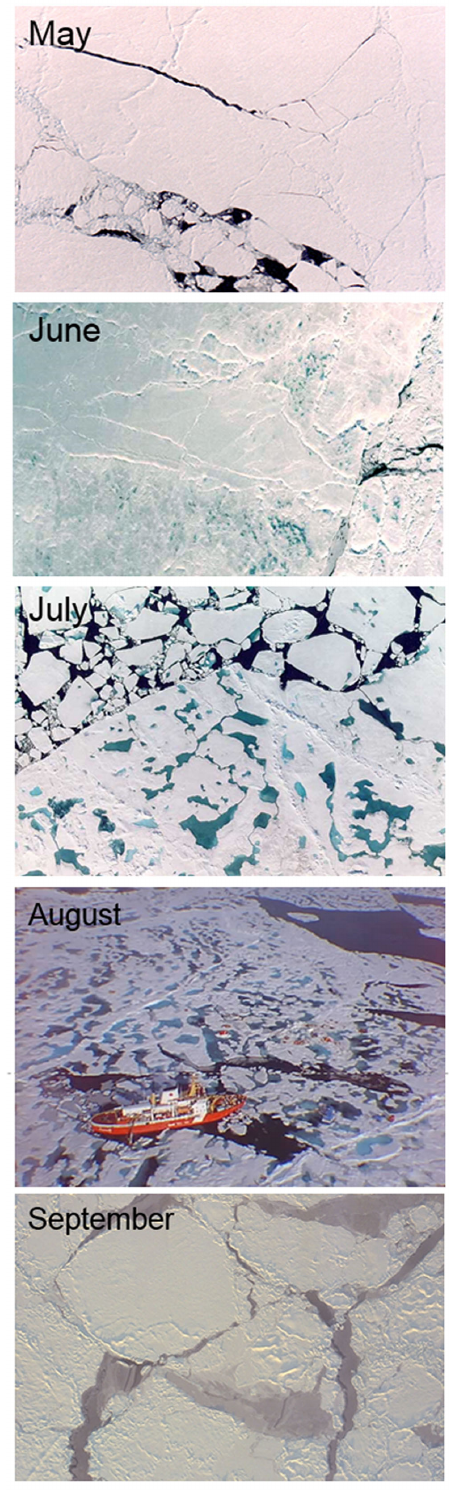
Figure 1. Aerial photographs showing the evolution of ice condi- tions from pre-melt in May through melt in June, July, and August and freeze-up in